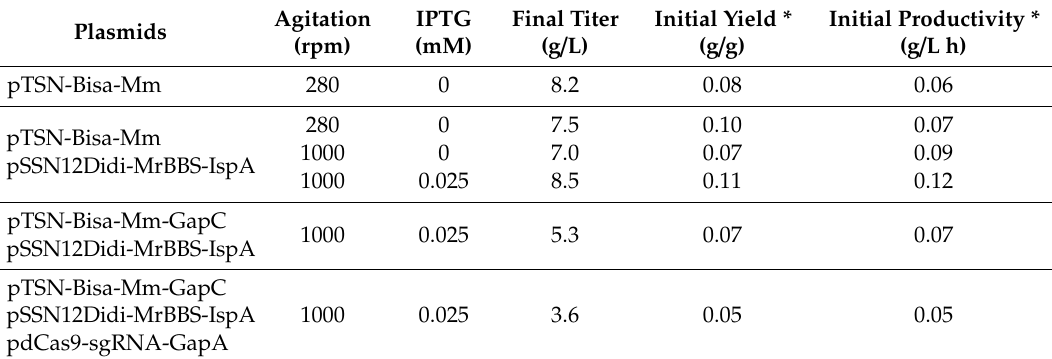
Table 1. Summary of fed-batch fermentations of ( − )- α -bisabolol by engineered E. coli . Plasmids